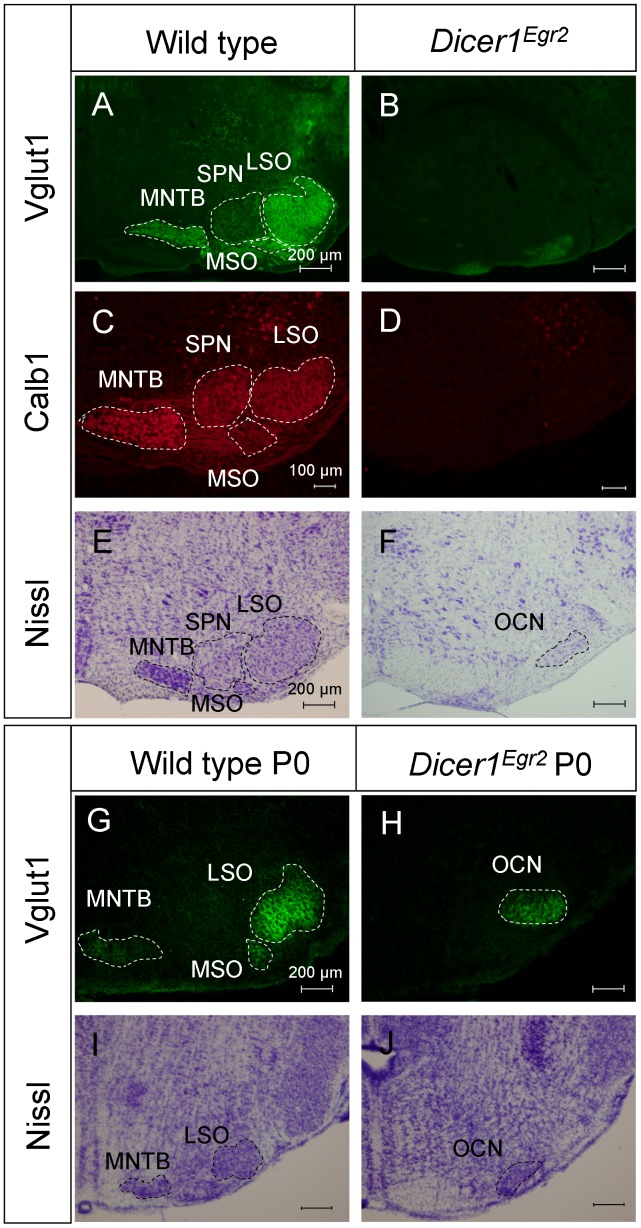
Severe disruption of the SOC in Dicer1Egr2 mice.
A–F Vglut1 immunoreactivity (A,B), Calb1 immunoreactivity (C,D), or Nissl stained sections (E,F) in the superior olivary complex of adult (P22– P30) wild type (A,C,E) or Dicer1Egr2 mice (B,D,F). Only weak Vglut1 staining is observed in the SOC of Dicer1Egr2 mice and principal nuclei such as the MNTB or the U-shaped LSO cell group are absent in these animals. Calb1 labeling is observed in somata of MNTB neurons and in the neuropil of the LSO, MSO, and SPN in wild type mice. No labeling is observed in Dicer1Egr2 mice. In Nissl stained sections, the cell groups of the MNTB and LSO are recognizable in control mice, but not in Dicer1Egr2 mice. The cell group at the ventral part in Dicer1Egr2 mice corresponds to the olivocochlear neurons. G–J Vglut1 immunoreactivity (G,H), or Nissl stained sections (I,J) in the superior olivary complex of P0 wild type (G,I) or Dicer1Egr2 mice (H,J). Vglut1 staining is restricted to the olivocochlear neurons in the SOC of Dicer1Egr2 mice, and principal nuclei such as the MNTB or the LSO cell group are absent in these animals. In Nissl stained sections, the cell groups of the MNTB and LSO are recognizable in wild type mice, but not in Dicer1Egr2 mice. The cell group at the ventral part in Dicer1Egr2 mice corresponds to the olivocochlear neurons. LSO, lateral superior olive; MNTB, medial nucleus of the trapezoid body; MSO, medial superior olive; OCN, olivocochlear neurons; SPN, superior paraolivary nucleus. Dorsal is up, lateral is to the right.